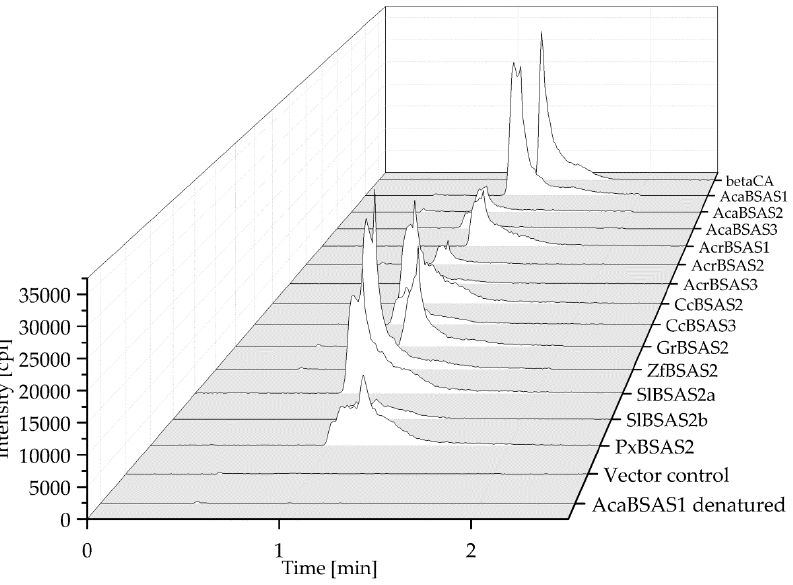
Figure 5. β-Cyanoalanine formation by lepidopteran BSAS. Purified recombinant AcaBSAS1, AcaBSAS2, AcaBSAS3, AcrBSAS1, AcrBAS2, AcrBSAS3, CcBSAS2, CcBSAS3, GrBSAS2, ZfBSAS2, SlBSAS2a, SlBSAS2b, PxBSAS2, heat denatured AcaBSAS1 or an equal volume of pooled elution fractions of the empty vector control were incubated with cysteine and cyanide in the presence of pyridoxal-5′-phosphate for 10 min. The reaction mixtures and a β-cyanoalanine standard (beta-CA) were analyzed by HPLC-MS/MRM. Shown are HPLC-MS/MRM traces depicting the m/z 112.7 to m/z 95.9 transition. Data for GrBSAS3 are shown with a different scale in Figure S2.